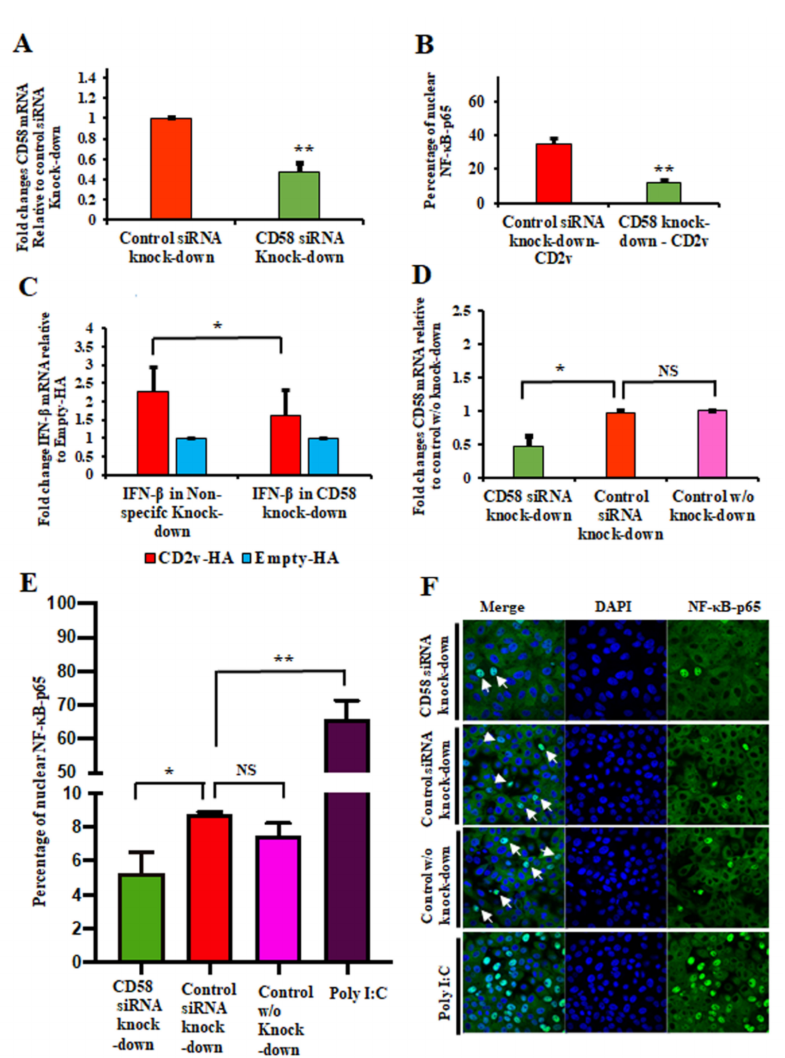
Figure 5. CD2v–CD58 interaction affects CD2v-mediated NF-kB-p65 nuclear translocation and IFN- β induction. ( A )